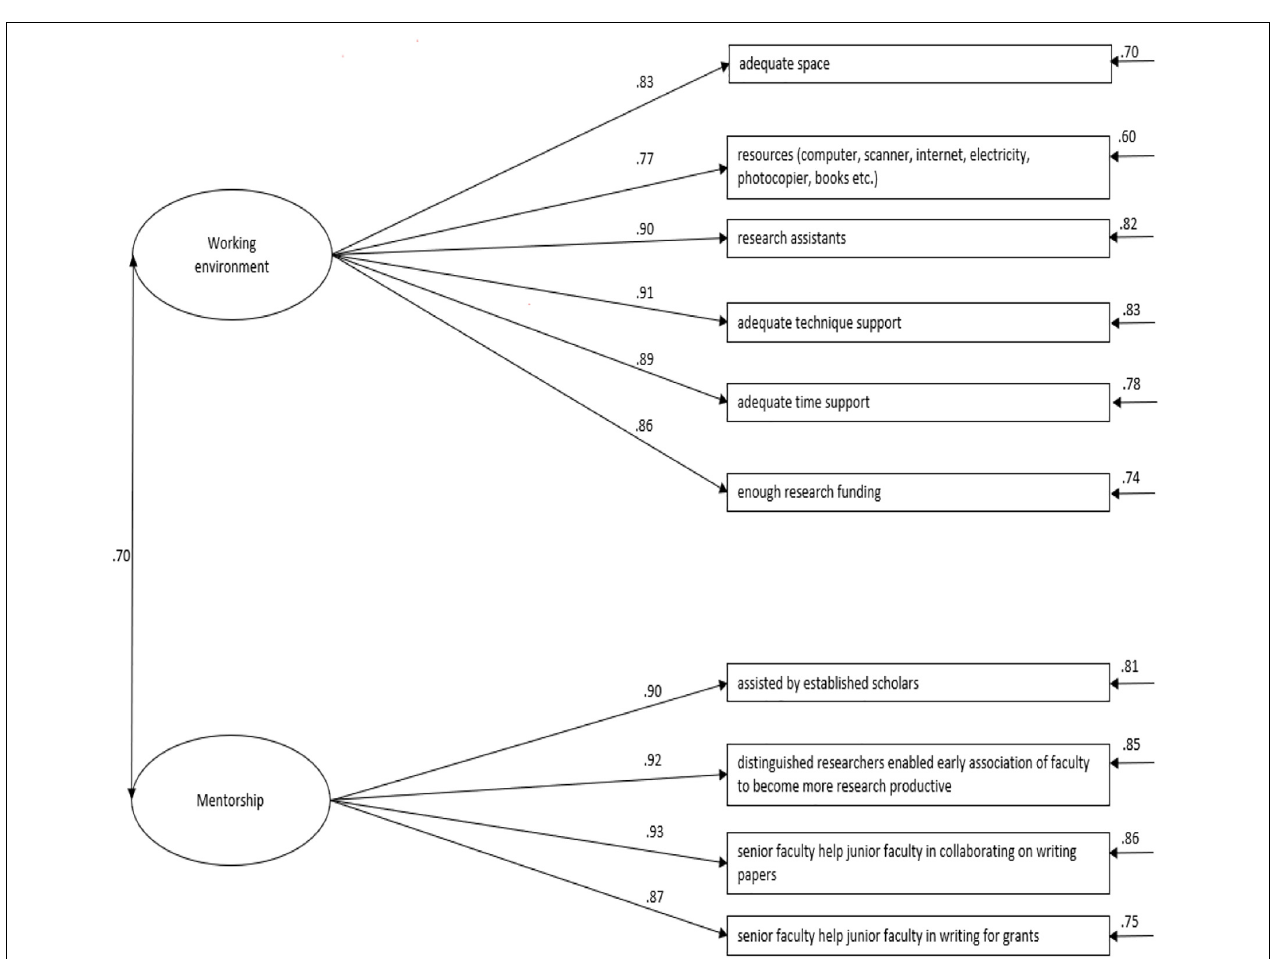
FIGURE 2 | The two-factor correlated model of institutional support on teacher research. Mentorship, mentorship support; working environment, working environment of teachers.